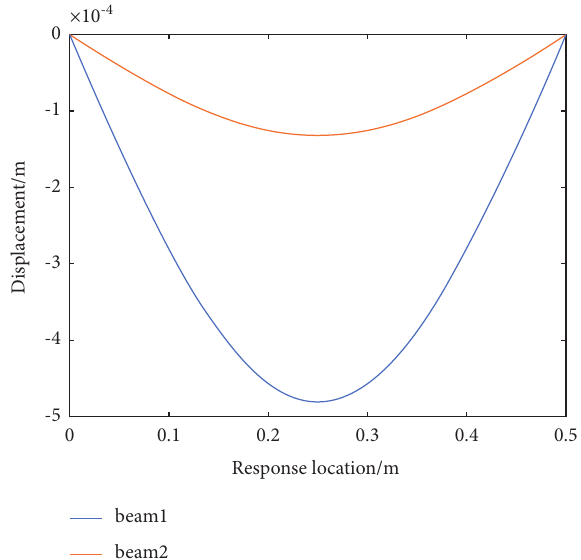
Figure 18: The mode response of the system at t � 0.5s.